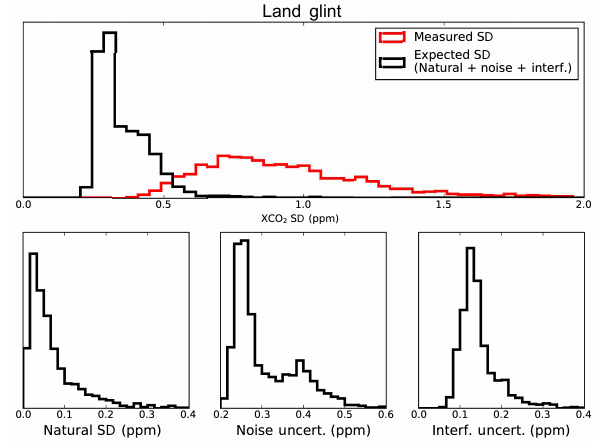
Figure A3. Same as Fig. A1 but for land glint.